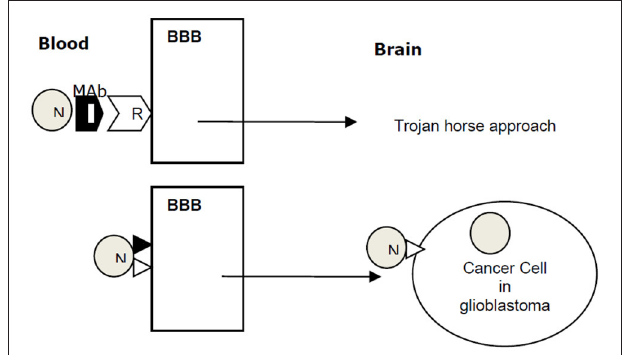
FIGURE 1 | A concept of targeted drug delivery to glioblastoma across the BBB. Nanoparticle (N) combined with a monoclonal antibody (MAb) for receptor (R) crosses the blood brain barrier (BBB) into brain by Trojan horse approach. N with a ligand targeting BBB traverses the BBB by receptor-mediated transcytosis. Ligand ◮ docks on a cancer cell receptor N (cid:3) and delivers anticancer payload to the cancer cell in glioblastoma.